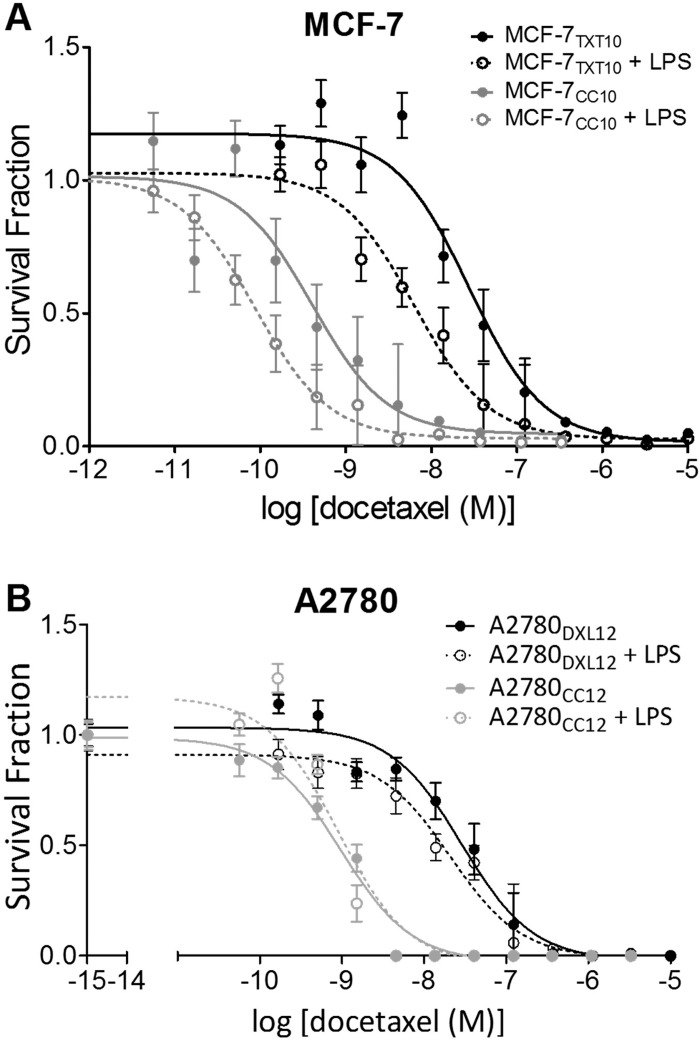
Effect of LPS exposure on tumor cell sensitivity to docetaxel.(A) Sensitivity to docetaxel was assessed using the clonogenic assay. MCF-7CC10 cells had an IC50 value for docetaxel of 0.4 nM docetaxel, and when pretreated with 10 μg/ml LPS, the value was reduced to 0.09 nM docetaxel. Likewise, MCF-7TXT10 cells exhibited an IC50 value for docetaxel of 27.6 nM docetaxel, which was reduced to 6.4 nM upon addition of 10 μg/ml LPS. Non-linear regression analysis comparing LPS-treated and LPS-absent curves revealed statistically significant differences in IC50 values (p<0.005). (B) Untreated and LPS-treated A2780CC12 cells both exhibited an IC50 value of 1.0 nM docetaxel. There was no significant difference in the IC50 values for docetaxel between LPS-treated and untreated A2780DXL12 cells (28.7 nM and 21.0 nM, respectively). Each data point is the mean of 12 microscopy field counts and each curve is representative of three replicate experiments, each showing a consistent trend.